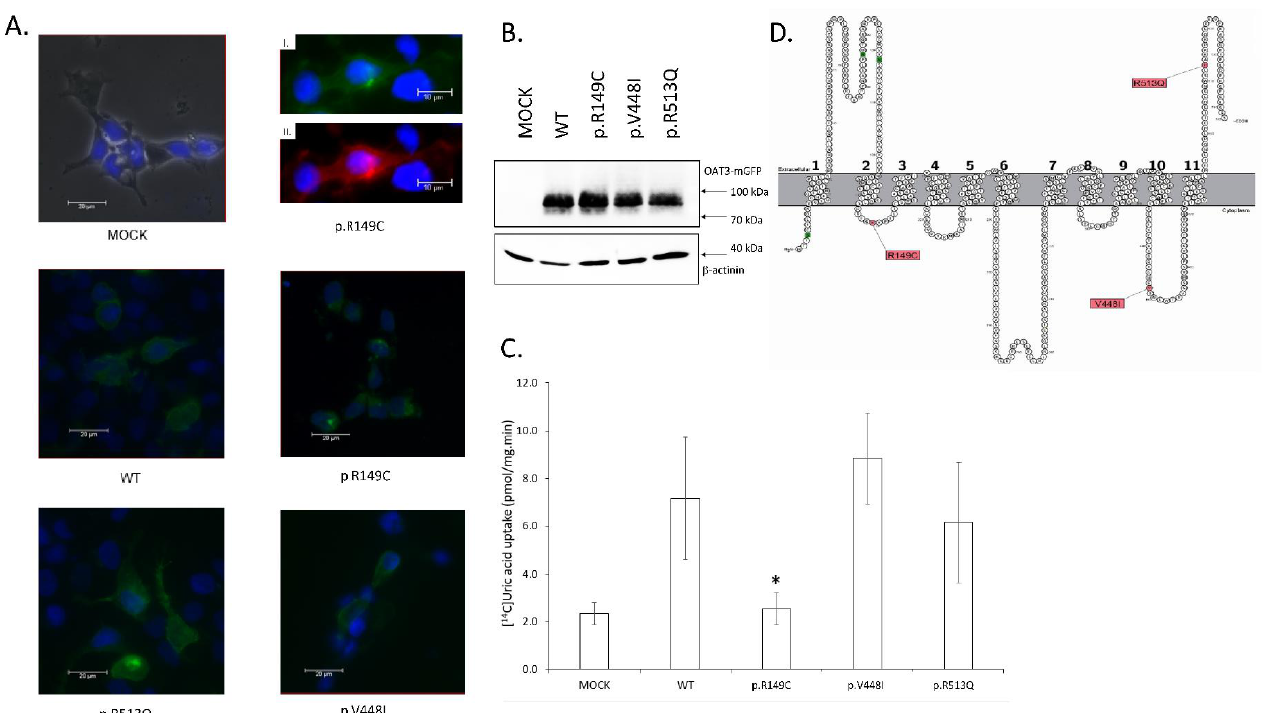
Figure 2. ( A ) Expression of SLC22A8 (OAT3) and it´s allelic variants in HEK293T cells line. Wild type protein was tagged with C-terminal GFP tag and cells was transiently transfected by polyethyleneimine lipofection. Samples was fixed by 4% paraformaldehyde and picture was take by Leica DM6 microscope in 400 × magnification. Plasmatic membrane localization was observed in all variants. Cell nucleus was stain by DAPI (blue). Higher magnification of allelic variant R149C of transporter OAT3 C-terminus tagged with GFP. Protein was expressed in HEK293 cell line. Cell nucleus was stain with DAPI. I. Fluorescence signal of GFP tagged protein. II. Cytoplasmatic membrane staining by PKH26 stain. ( B ) Immunoblotting of HEK293T transfected by OAT3 WT and its allelic variant. Fusion protein OAT3-mGFP had majority band with molecular weight 90 kDa. CapZ ( β -actinin) protein is used as loading control and it had one major band with 42 kDa molecular weight. ( C ) Transport of 14 C radiolabeled uric acid by HEK293 cells transfected by OAT3 WT and its allelic variants. The data are shown as pmol uric acid transported into the cytoplasm per one minute and per total protein in cell lysate. Data are expressed with ± SD, n = 2. Statistical analyses for significant differnces was calculate by Students t -test (*, p < 0.05). ( D ) Topological model of human OAT3 protein (encoded by gene SLC22A8 ). Allelic variants p.R149C, p.V448I and p.R513Q (single amino acid exchange) are colored by pink color. Putative glycosylation motifs are colored by green (for OAT3 is no experimental evidence for glycosylation). Edited on the base